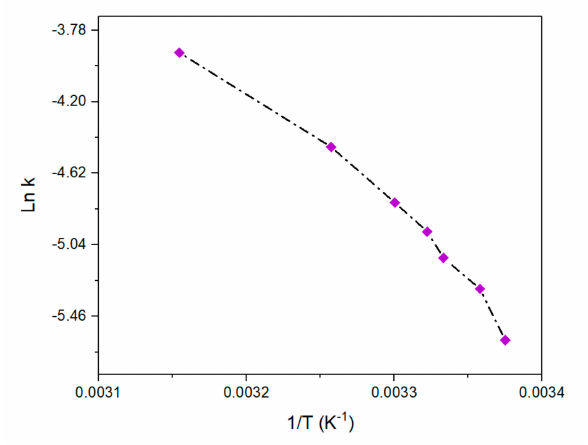
Figure 10. Arrhenius plots of ln k versus 1 / T for the Pd nanoparticles at a constant concentration of 4-nitrophenol (7.38 × 10 − 5 M) and NaBH 4 (150 eq). The rate constant k is obtained from fitting the experimental data with the Langmuir–Hinshelwood model (see Table